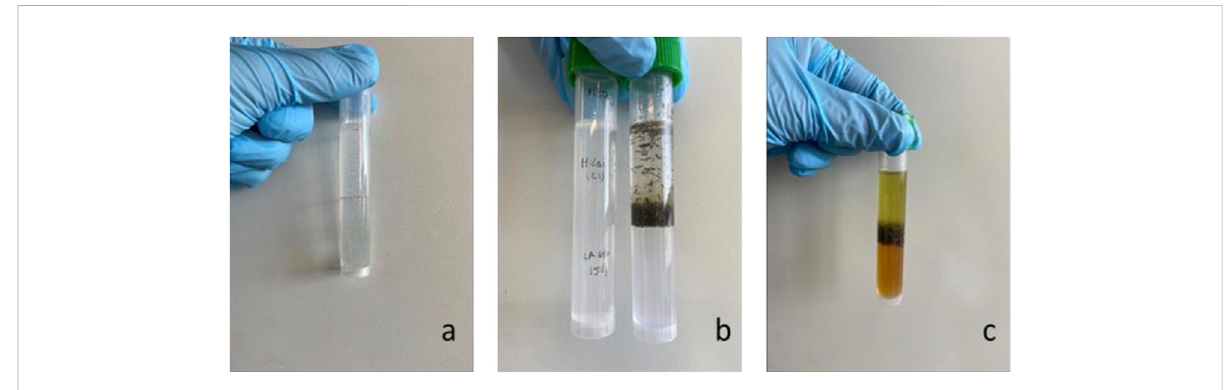
FIGURE 2 BiphasicsystemwithnonpolarandpolarNADESs (A) ;biphasicsystemwithnonpolarandpolarNADESsbeforeextraction (B) andafterextraction (C) . System represented: Me:Lau (2:1) on top and La:Glu (5: I)